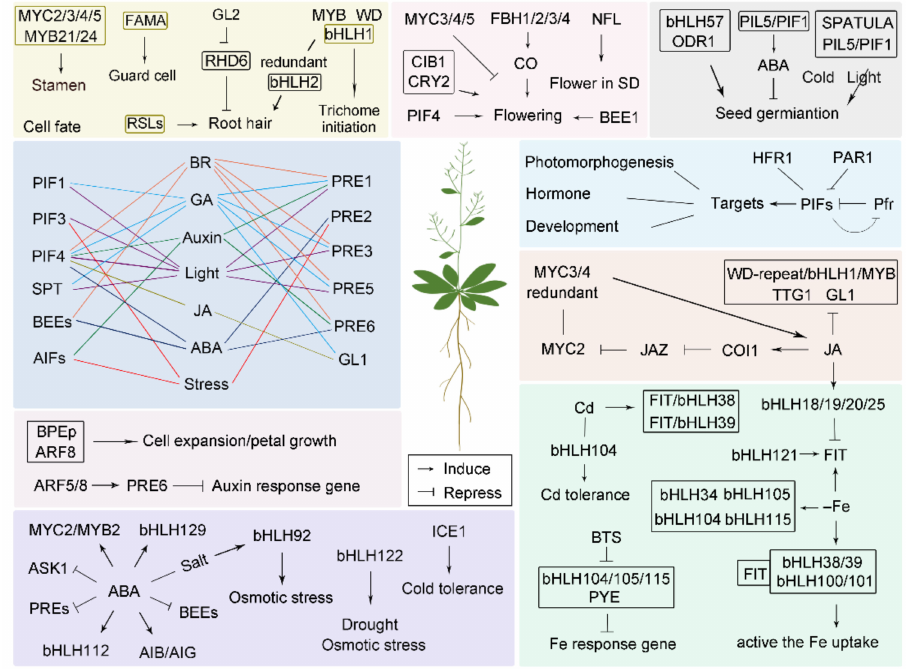
Figure 1. bHLHs functions in various signaling